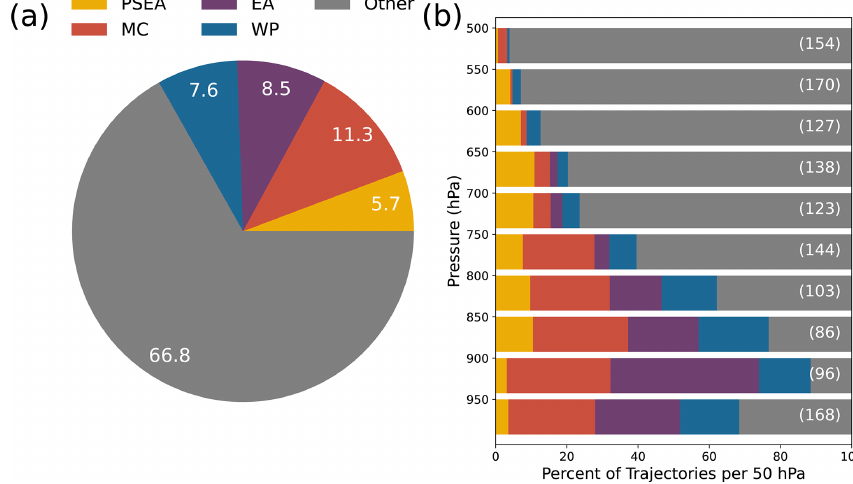
Figure 4. Relative contributions (in percentages) of air masses arriving from study regions averaged over (a) all altitudes and (b) pressure levels (hPa). Total number of trajectories per pressure bin is provided at the right end of (b) . Source regions are peninsular Southeast Asia (PSEA), the Maritime Continent (MC), East Asia (EA), and the West Pacific (WP).